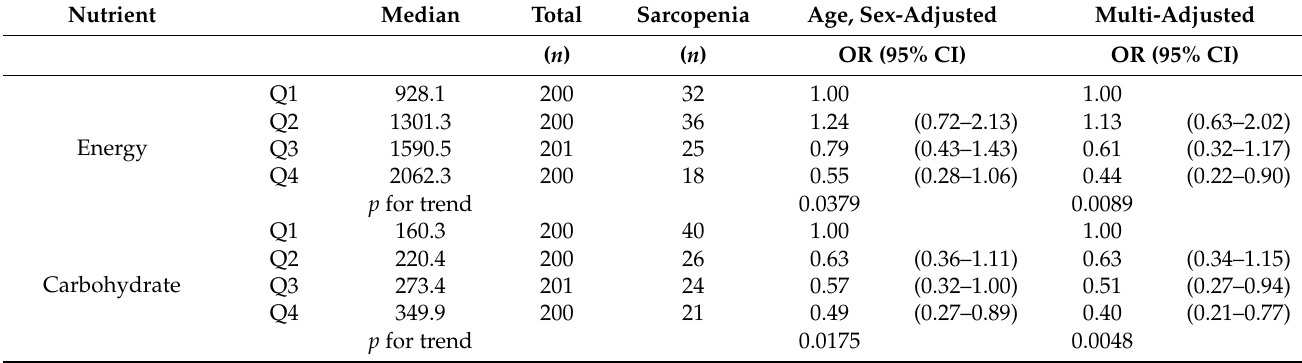
Table 6. Odds ratios (OR) and 95% confidence intervals (CI) of sarcopenia by quartiles (Q) of nutrient